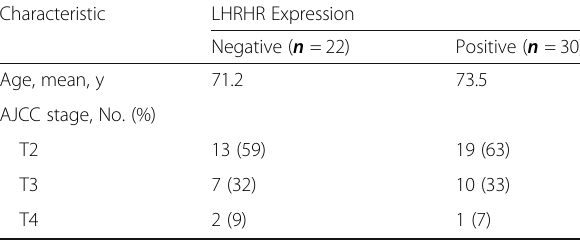
Table 1 Characteristics of Patients with Muscle-Invasive Urothelial Carcinoma, Stratified by LHRHR Expression ( n = 52) Characteristic LHRHR Expression